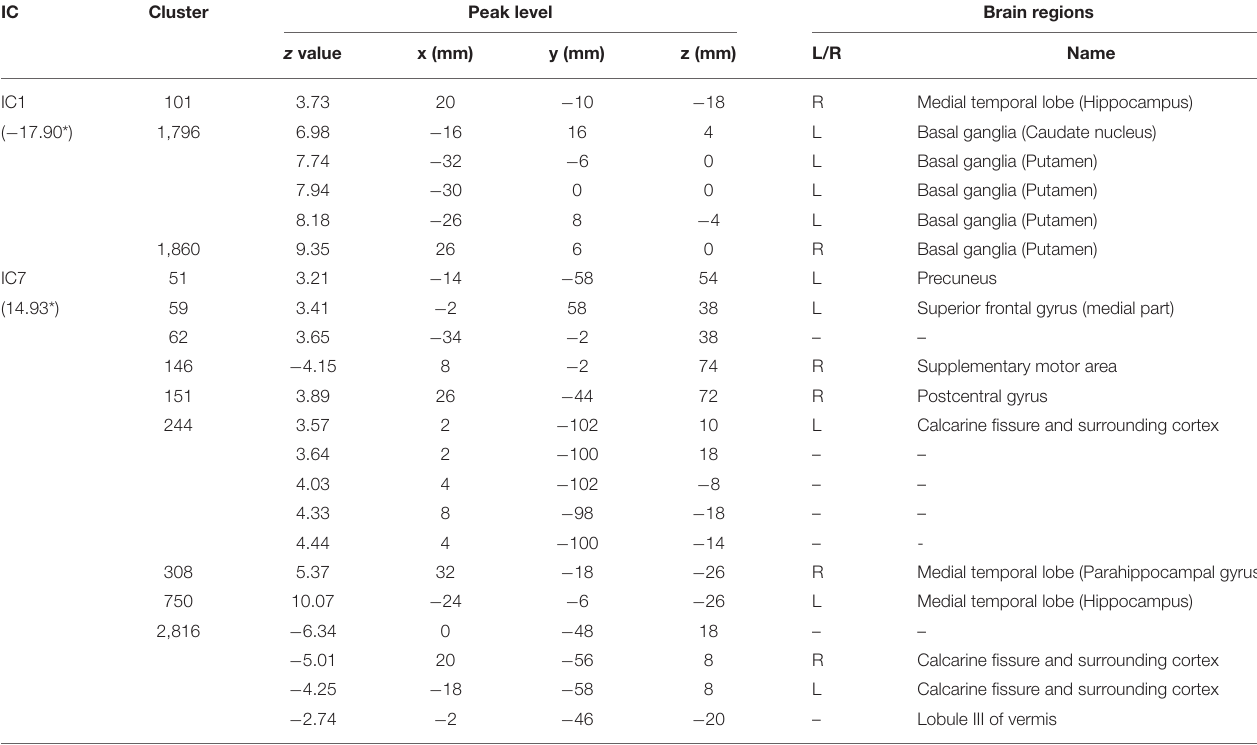
TABLE 4 | The significant brain regions (|z| > 2.58, p < 0.01, cluster extent ≥ 50 voxels) included in the two sign-corrected independent components corresponding to the first two weights in the rank of the absolute values of all weights of the logistic regression model. IC Cluster Peak level Brain